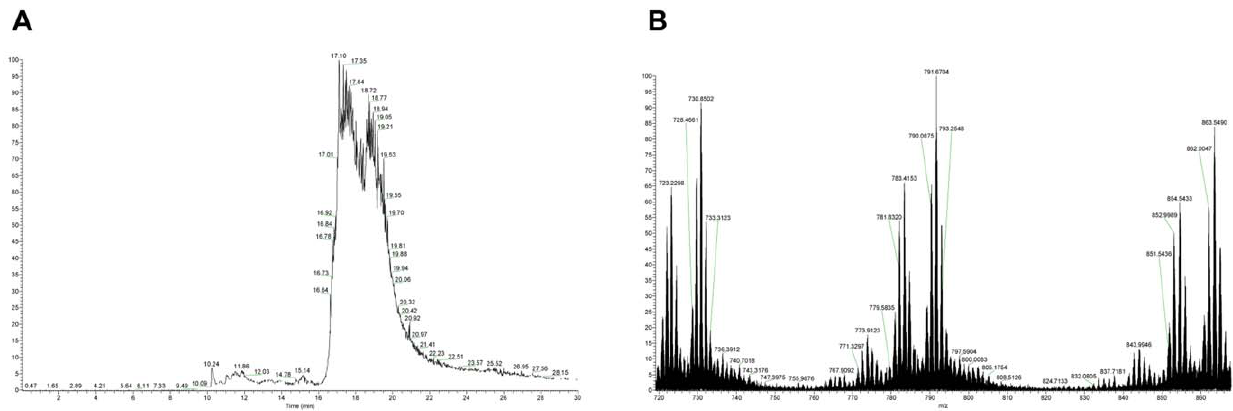
Figure 4. Eluate from the affinity column of non-digested oxidized synthetic hPTH(1–84)ox. A : NanoLC-ESI-FTMS total ion chromatogram. B : Magnified summed FTMS spectrum for retention time interval of 16.50–18.50 minutes. Several different charged analyte ions of PTH eluate were detected. doi:10.1371/journal.pone.0040242.g004 PLoS ONE |